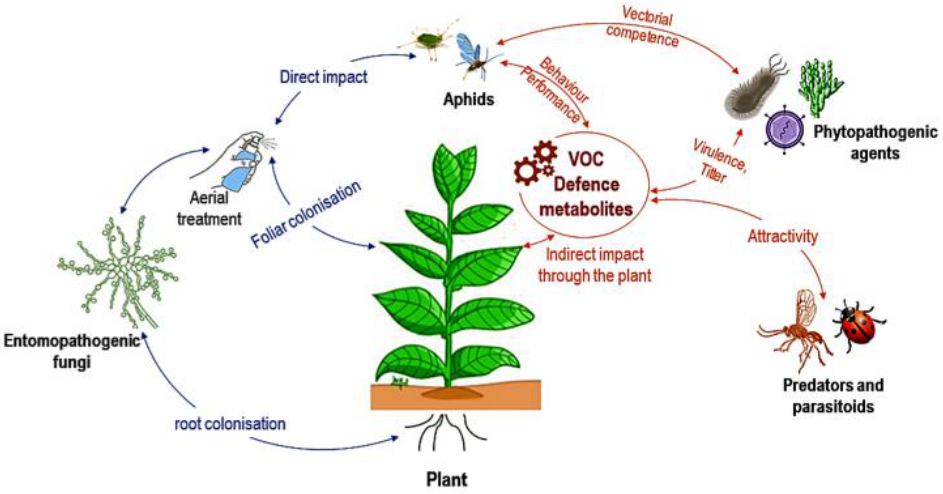
Figure 2. Direct and indirect effects of entomopathogenic fungi treatments on aphids, plants, plant pathogens and insect beneficials in a multidimensional interaction.